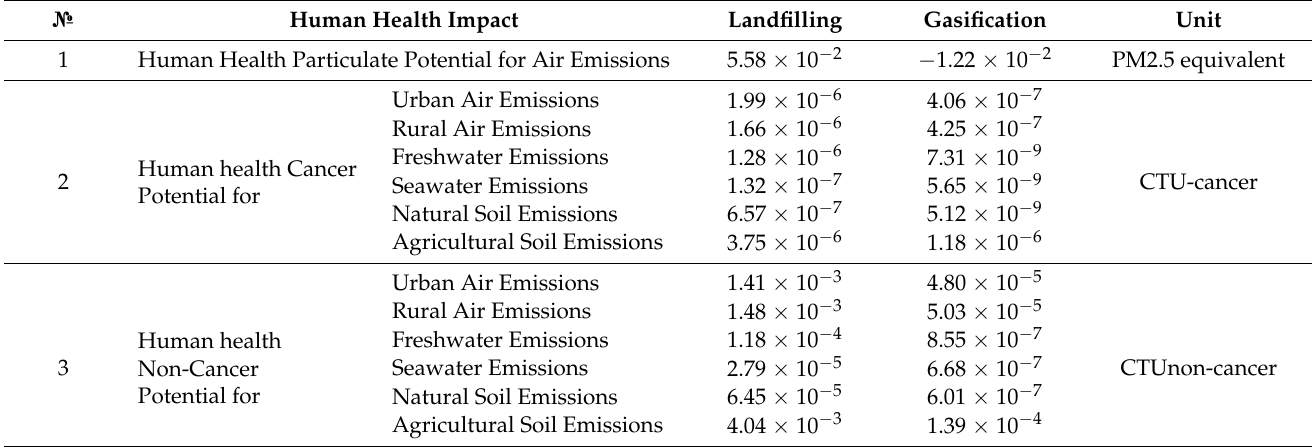
Table 6. Human Health